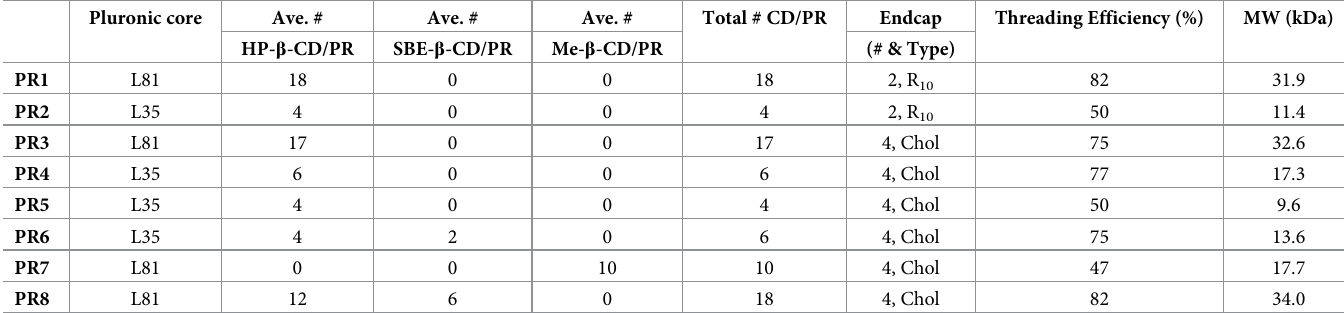
Table 1. Compositions observed for TAEA-Pluronic polyrotaxane library prepared by hexane solvent-assistance. Pluronic core Ave. # Ave. #